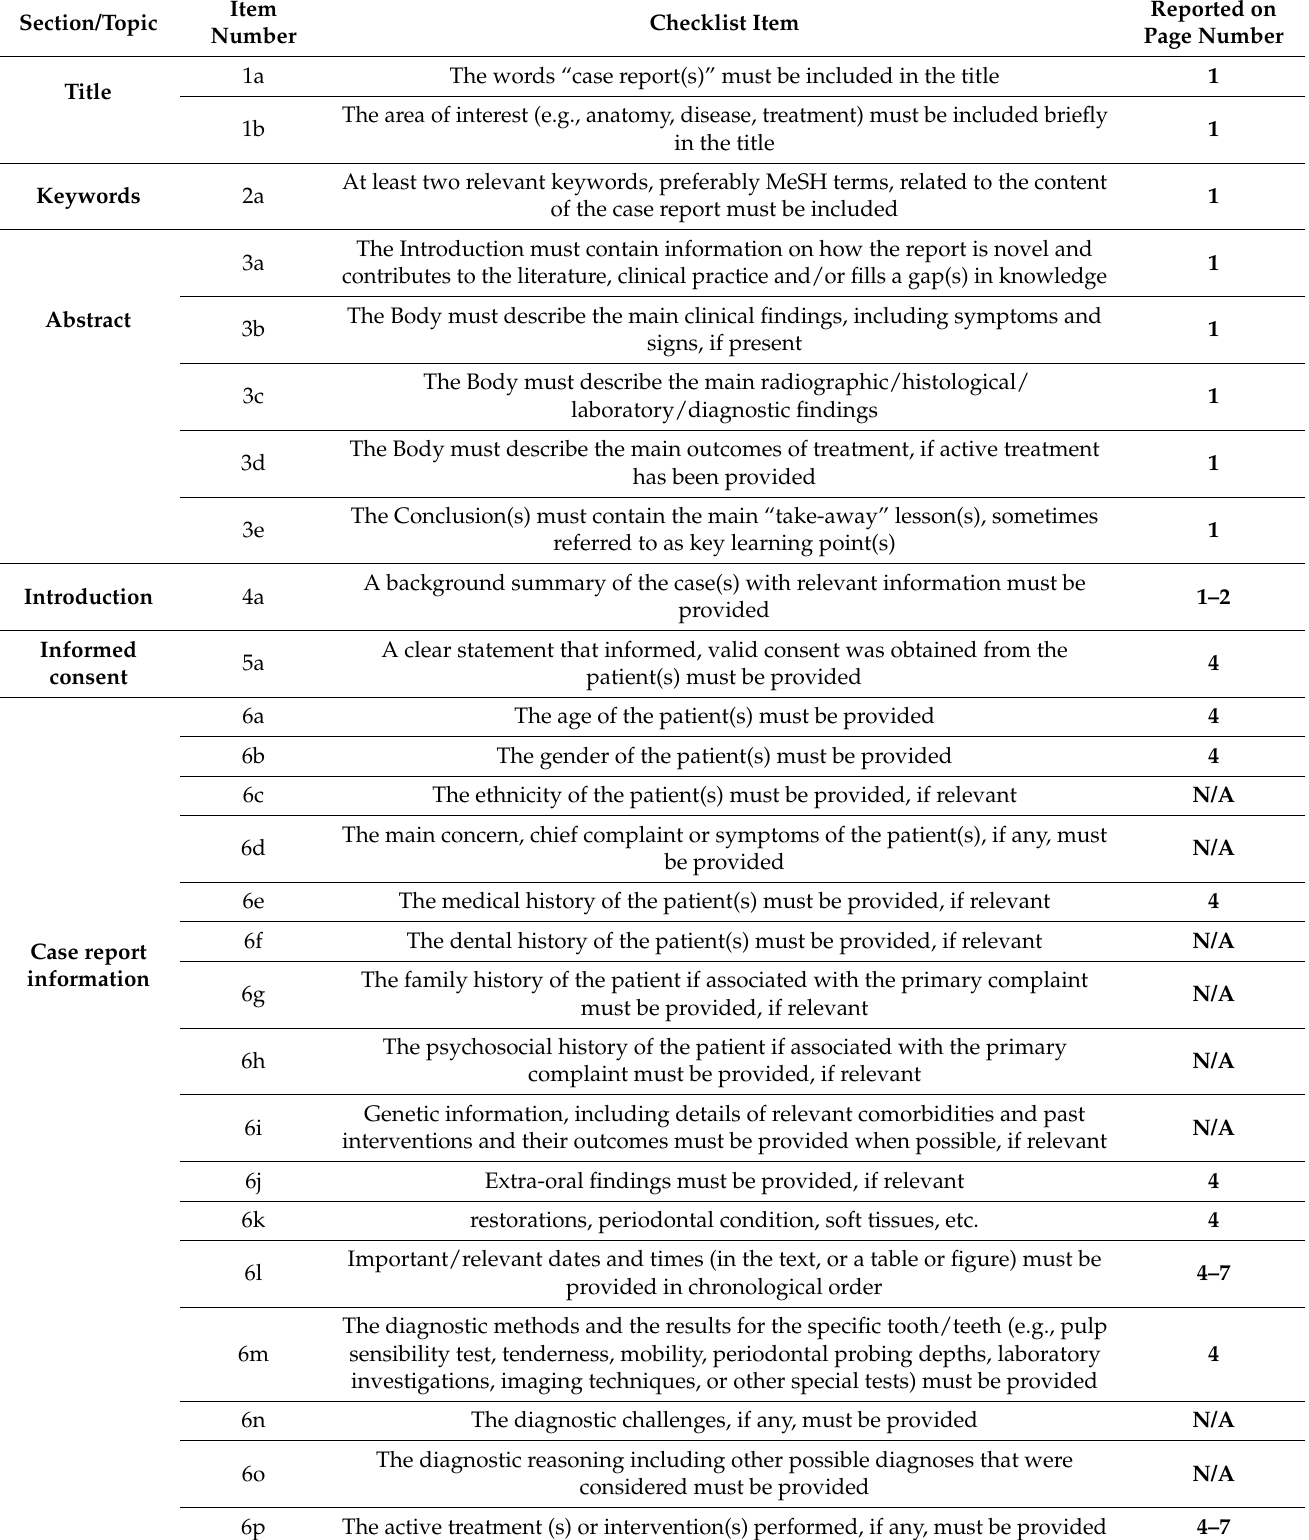
Table A1. PRICE 2020 checklist of the present case